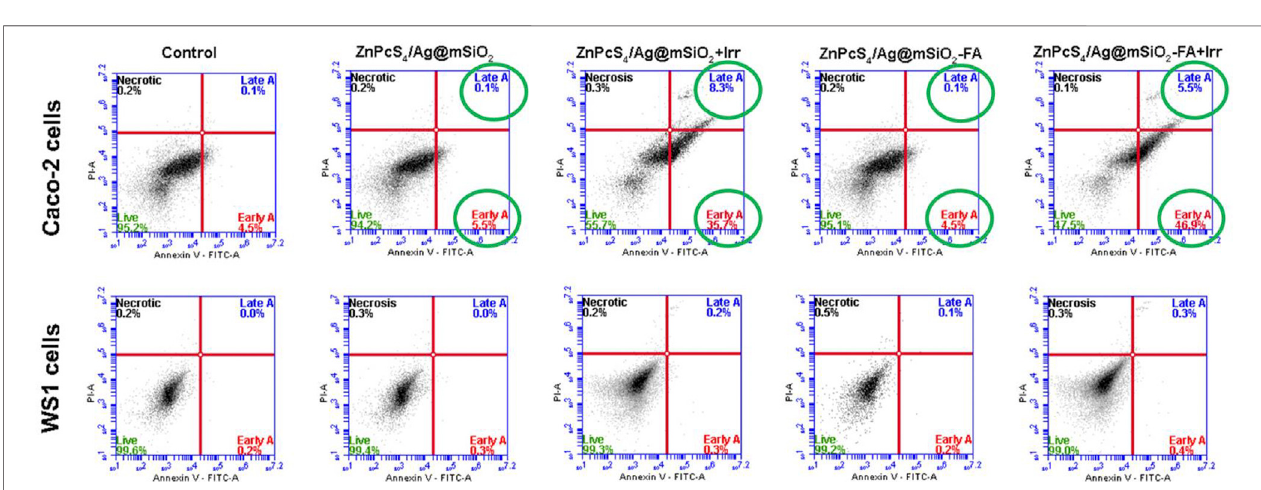
FIGURE 6 | Annexin V-FITC/PI cell death analysis of Caco-2 and WS1 cells using fl ow cytometry, 20 hr post-irradiation with passive and actively targeted NCs under the equivalent concentration of ZnPcS 4 (0.125 µM, 10 J/cm 2 fl uency). Cells with no treatment (PS/irradiation) were used as a control.